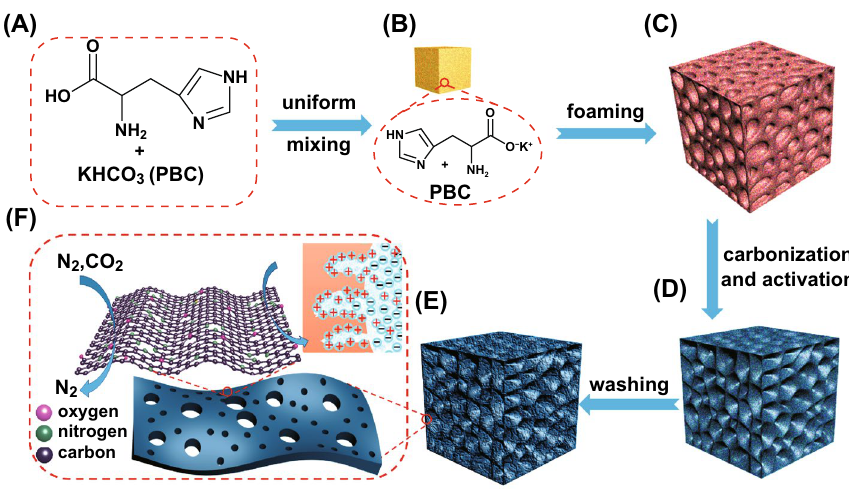
tion and chemical activation at high temperatures, E the HPNCFs obtained after washing by water, and F structure model of the HPNCFs and their applications in